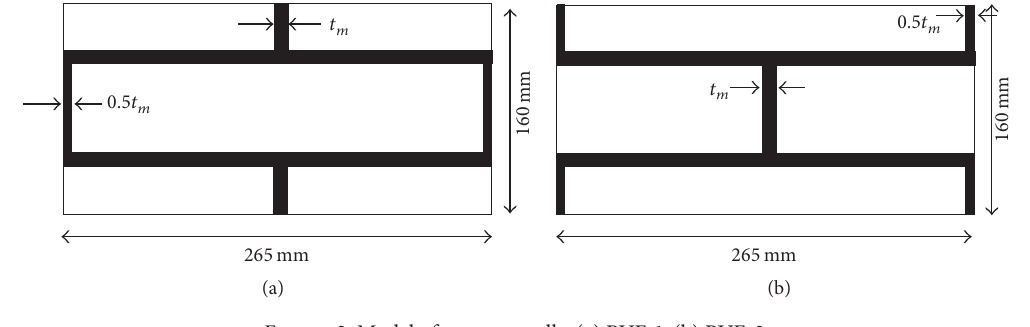
Figure 2: Model of masonry cells: (a) RVE-1; (b) RVE-2.